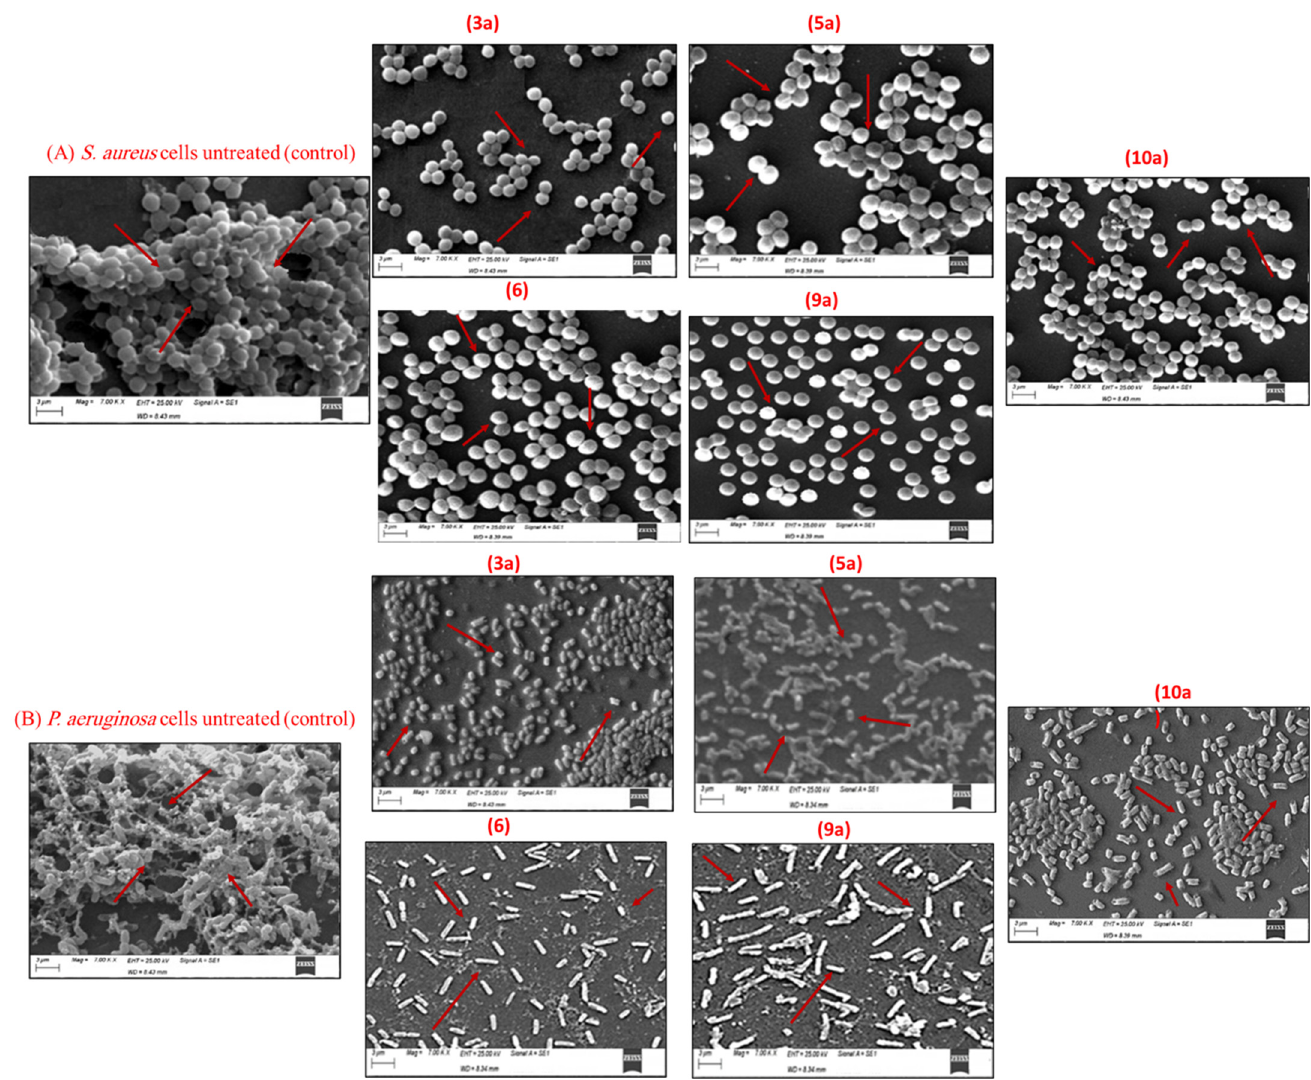
Figure 3. Microscopic visualization of antibiofilm activity of pyrazole compounds. ( A ) Scanning electron micrographs of S. aureus cells untreated (control) and treated with 1XMIC of each pyrazole derivative at 7000 × magnification. ( B ) Scanning electron micrographs of P. aeruginosa cells untreated (control) and treated with 1XMIC of each pyrazole derivative at 7000 ×